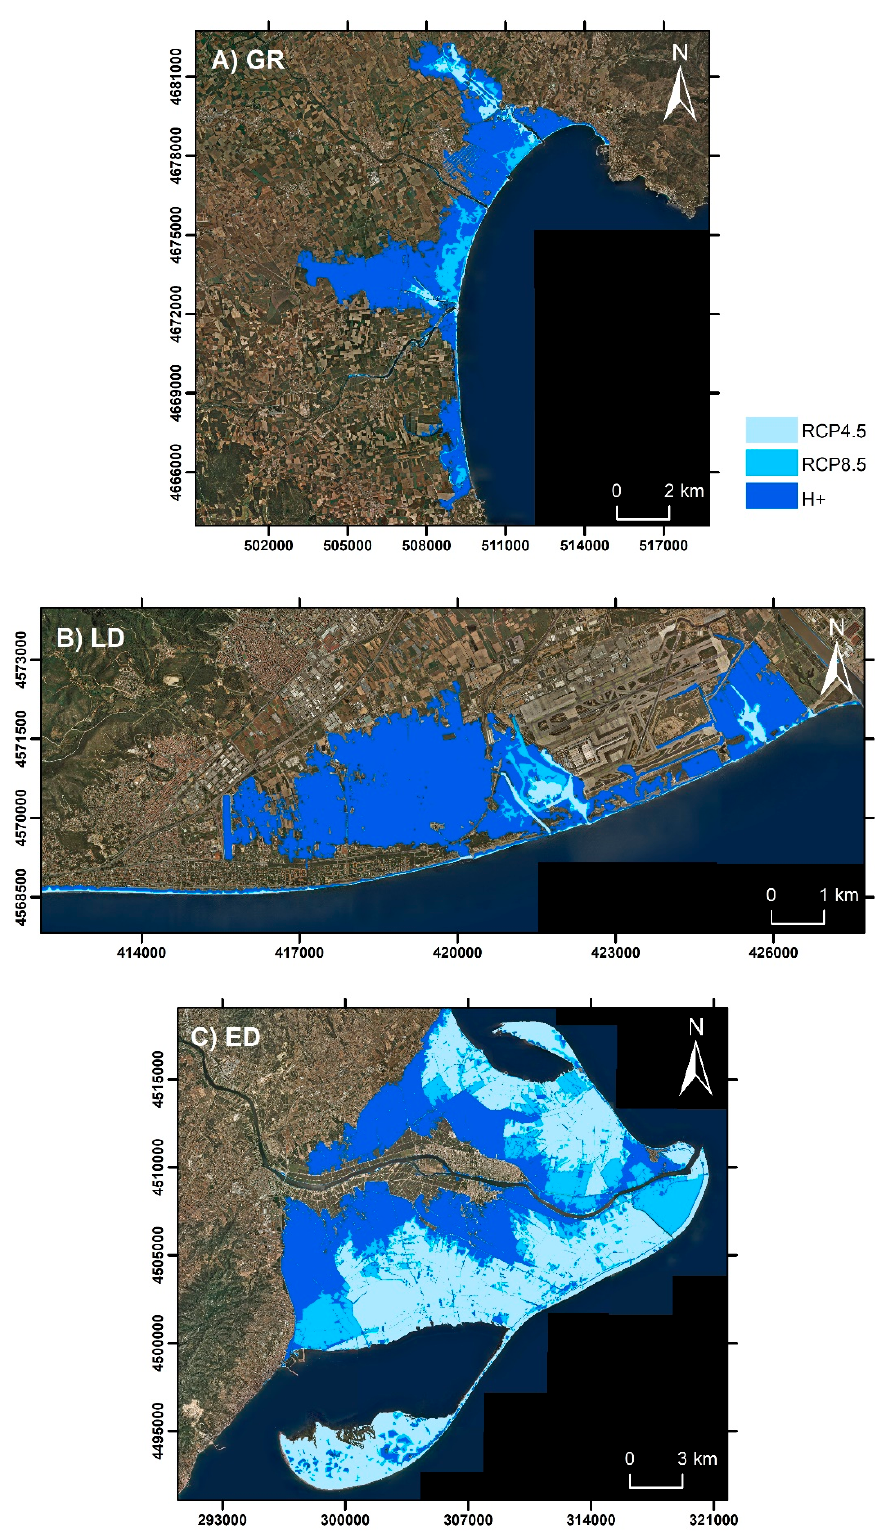
Figure 7. Inundation extent for 2100 under different SLR-scenarios at the ( A ) Gulf of Roses (GR), ( B ) Llobregat Delta (LD), ( C ) ED. (The geographic coordinate system is ETRS89/UTM zone 31N).